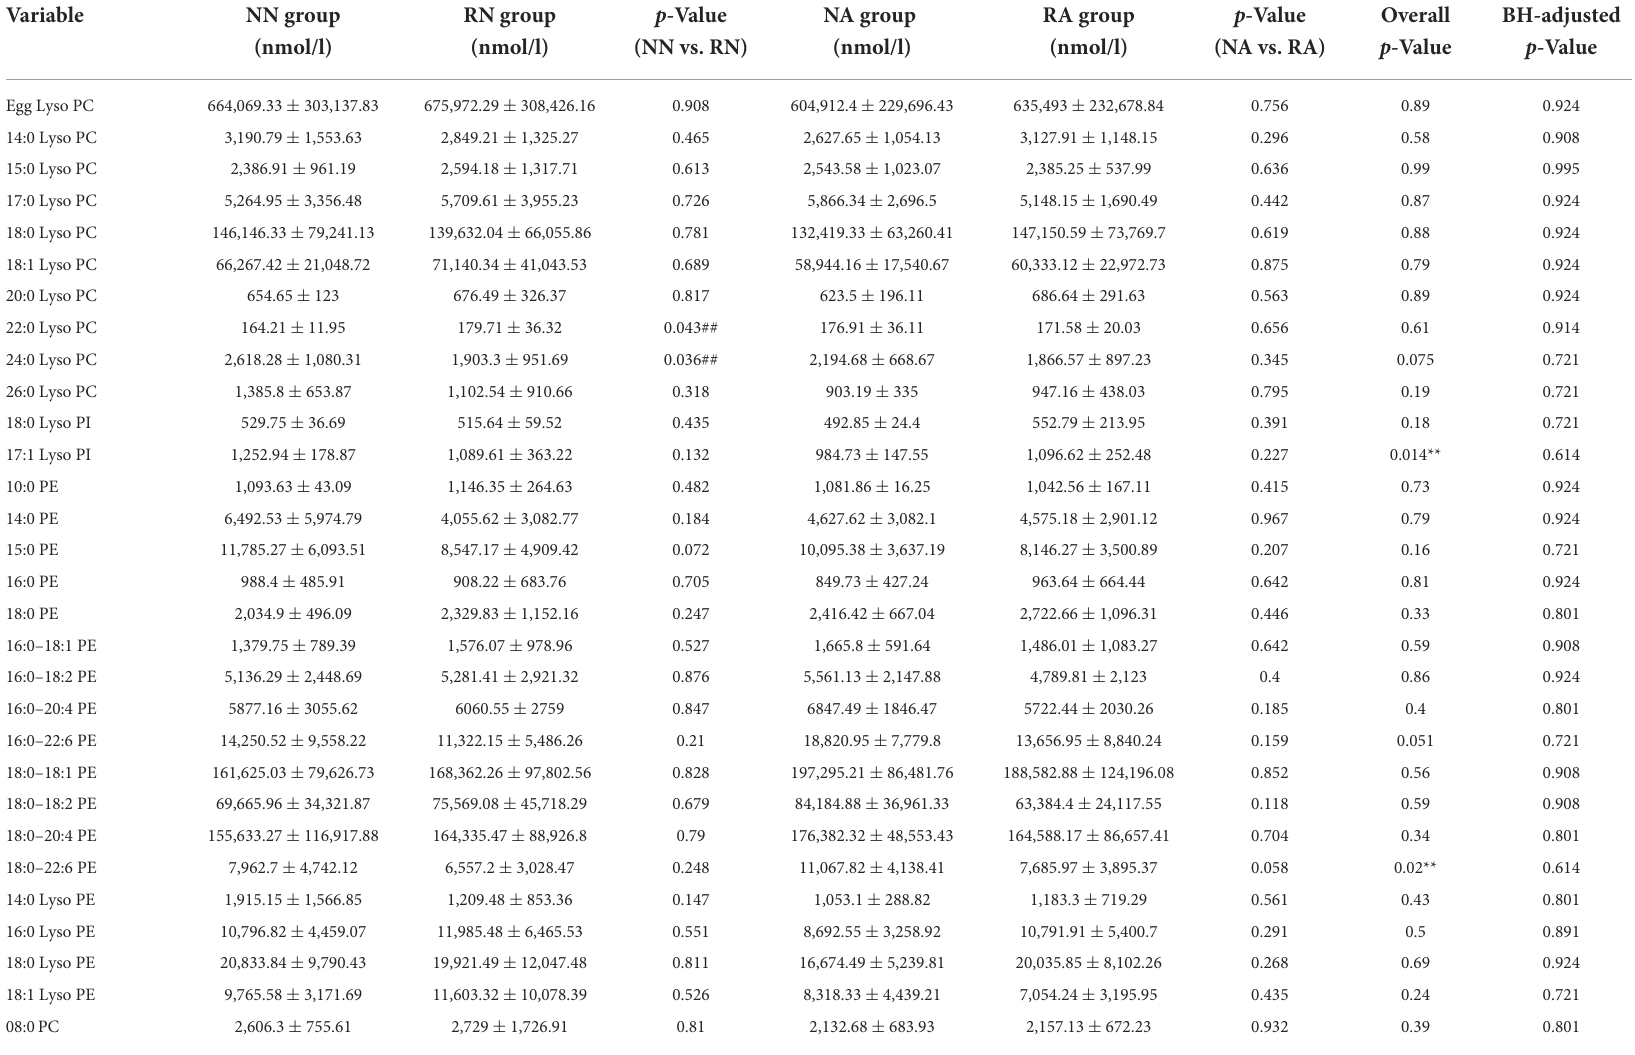
TABLE 2 Lipids that discriminate rotator cuff tear a